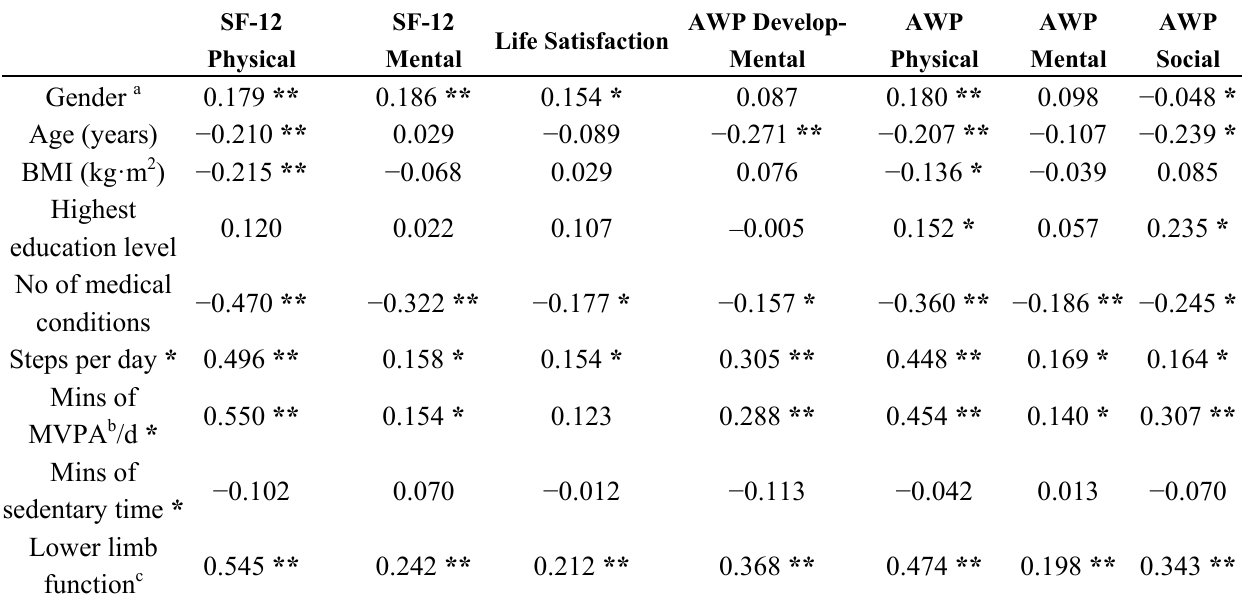
Table 2. Associations of subjective well-being with participant characteristics, steps, MVPA, sedentary time and lower limb